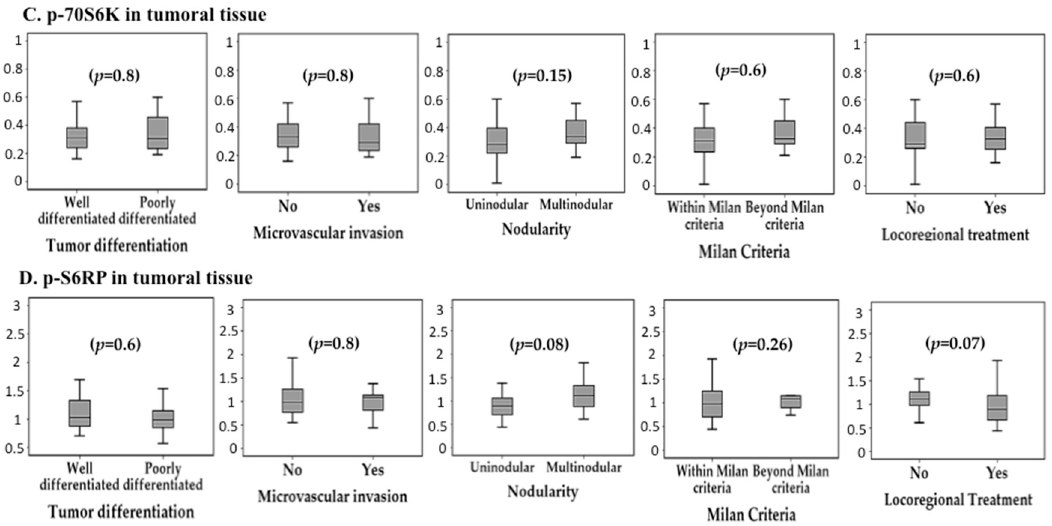
Figure 2. Association between histological features of hepatocellular carcinoma and average intra-tumour expression (I/mm 2 ) of the evaluated mTOR pathway components: ( A ) p-Akt, ( B ) p-AMPK, ( C ) p-70S6K and ( D ) p-6SRP.